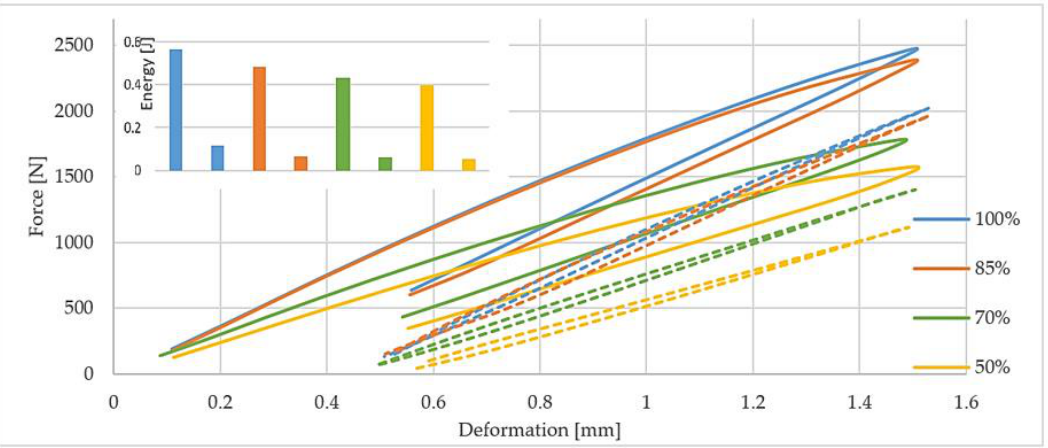
Figure 8. Influence of the percent of infill added to the samples produced by 3D printing on the shape of thehysteresisloopsobtainedafter1stand50thloadcyclesSolidline—firstloop,